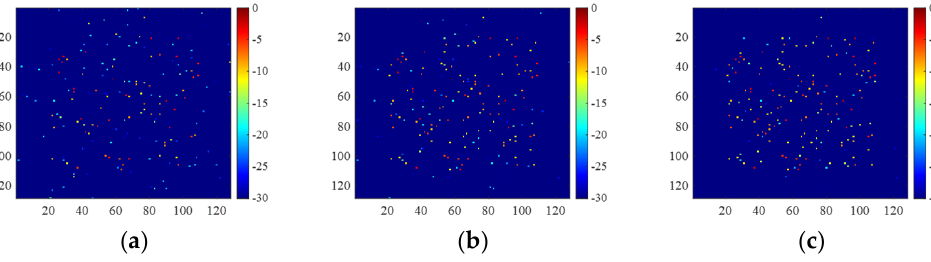
Figure 17. Images generated using 25% of available data with SNRs of ( a ) 0 dB, ( b ) 5 dB, and ( c ) 10 dB.